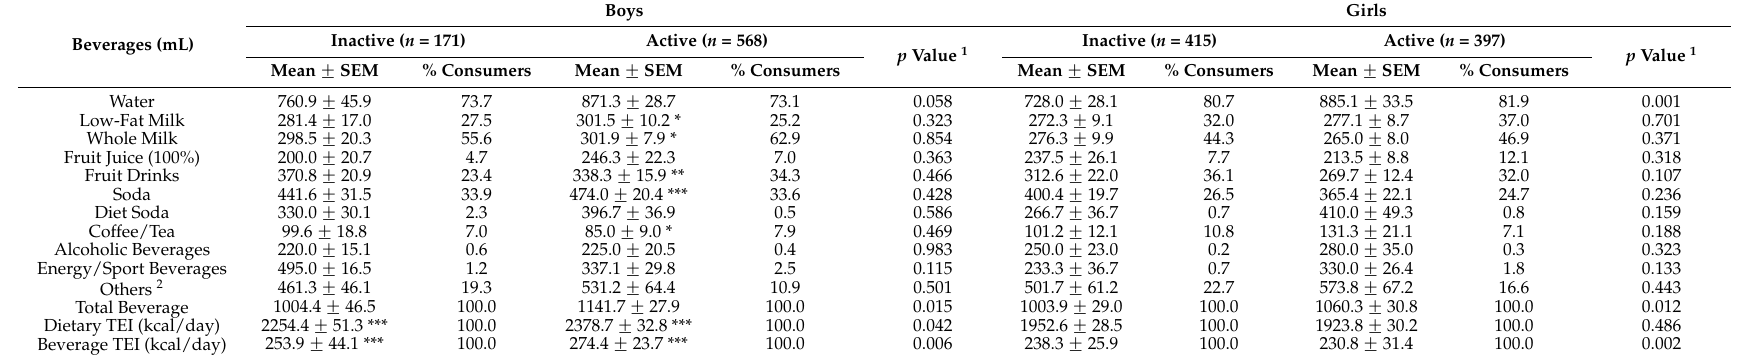
Table 2. Daily beverage (mL), energy intake and percentage of consumers among active and inactive adolescents.